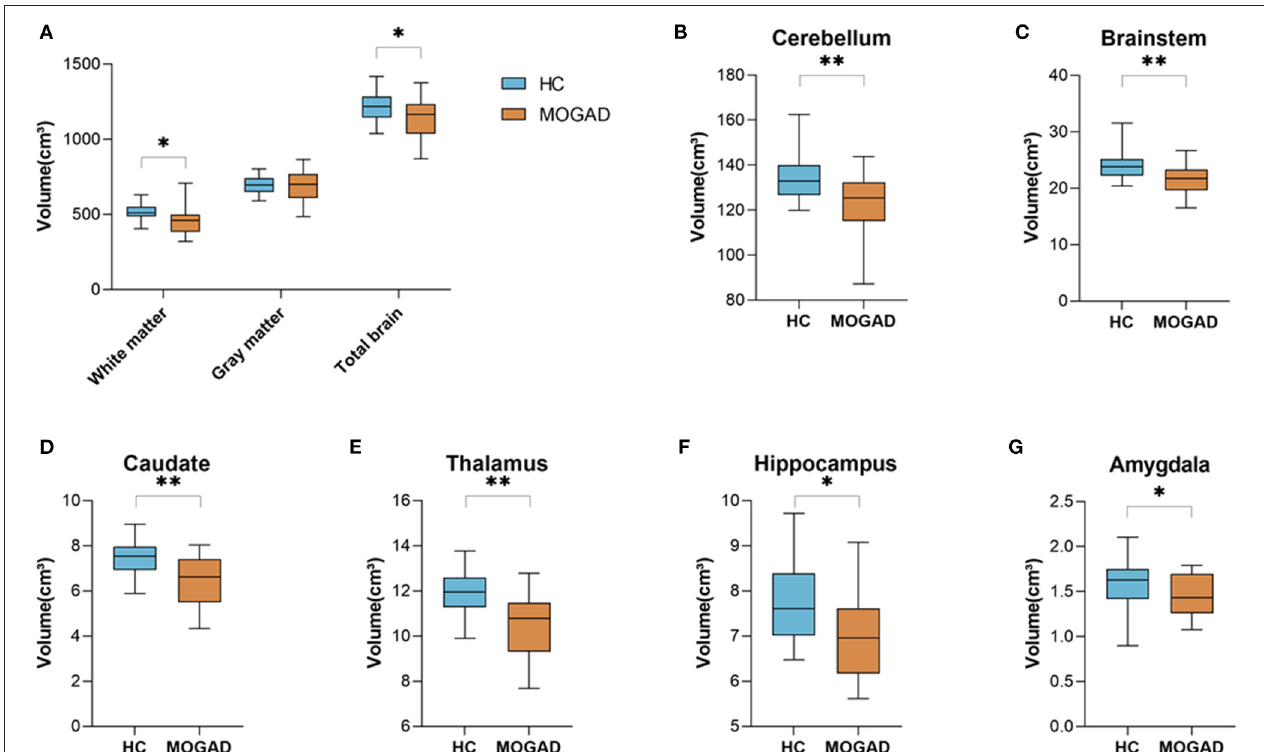
FIGURE 1 | Decreased brain volume in MOGAD patients compare to HCs. Brain volume of HCs ( n = 22) and MOGAD patients ( n = 22) analyzed by Volbrain software. (A) Volume of white matter (512.56 ± 57.33 vs. 458.68 ± 89.60, p = 0.018), gray matter (699.97 ± 59.45 vs. 681.66 ± 106.70, p = 0.476) and total brain (1,214.14 ± 105.65 vs. 1,139.91 ± 135.15, p = 0.048), and volume of (B) cerebellum (134.64 ± 10.28 vs. 124.17 ± 12.42, p = 0.007), (C) brainstem (23.96 ± 2.55 vs. 21.61 ± 2.45, p = 0.003), (D) caudate (7.46 ± 0.79 vs. 6.56 ± 1.03, p = 0.001), (E) thalamus (11.97 ± 0.98 vs. 10.74 ± 1.72, p = 0.008), (F) hippocampus (7.78 ± 0.83 vs. 6.86 ± 1.27, p = 0.011), and (G) amygdala (1.60 ± 0.27 vs. 1.37 ± 0.36, p = 0.024) of MOGAD patients and HCs. MOGAD, Myelin oligodendrocyte glycoprotein antibody disorders; HCs, healthy controls. p * ≤ 0.05, ** ≤ 0.01.